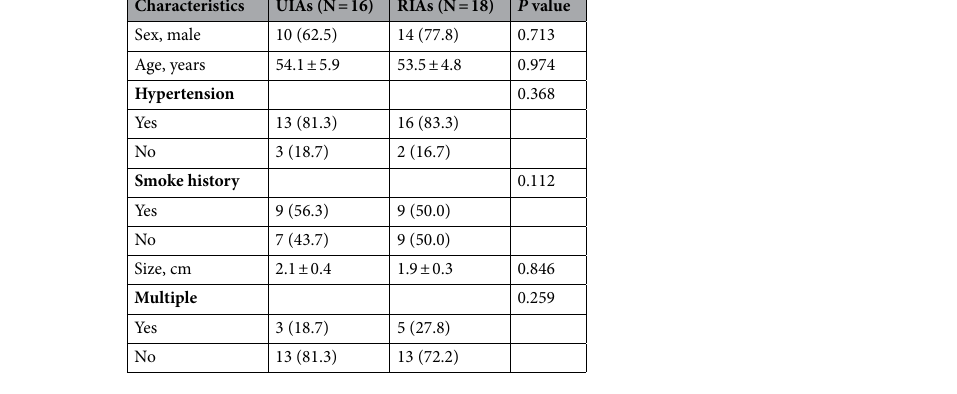
Table 1. Basic clinical features of recruited